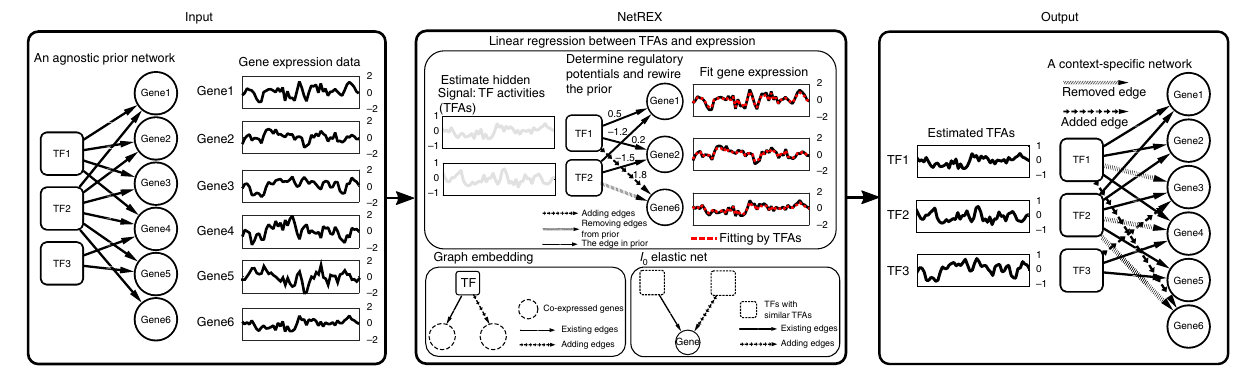
Fig. 1 Schematic outline of NetREX using a simulated example with 3 TFs, 6 target genes and their